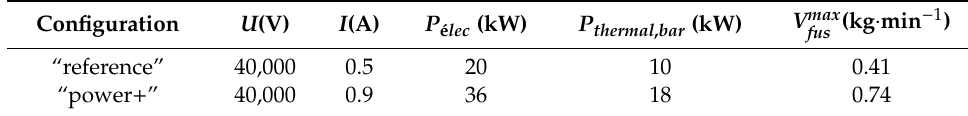
Table 7. New operating conditions compared to the reference case.